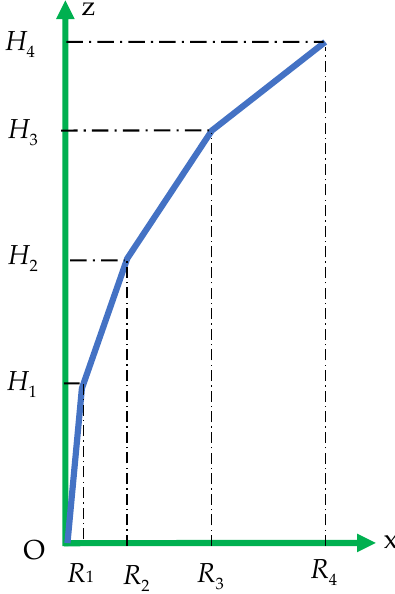
Figure 32. Bending variation. Table 9. Bending values depending on structure material and height.